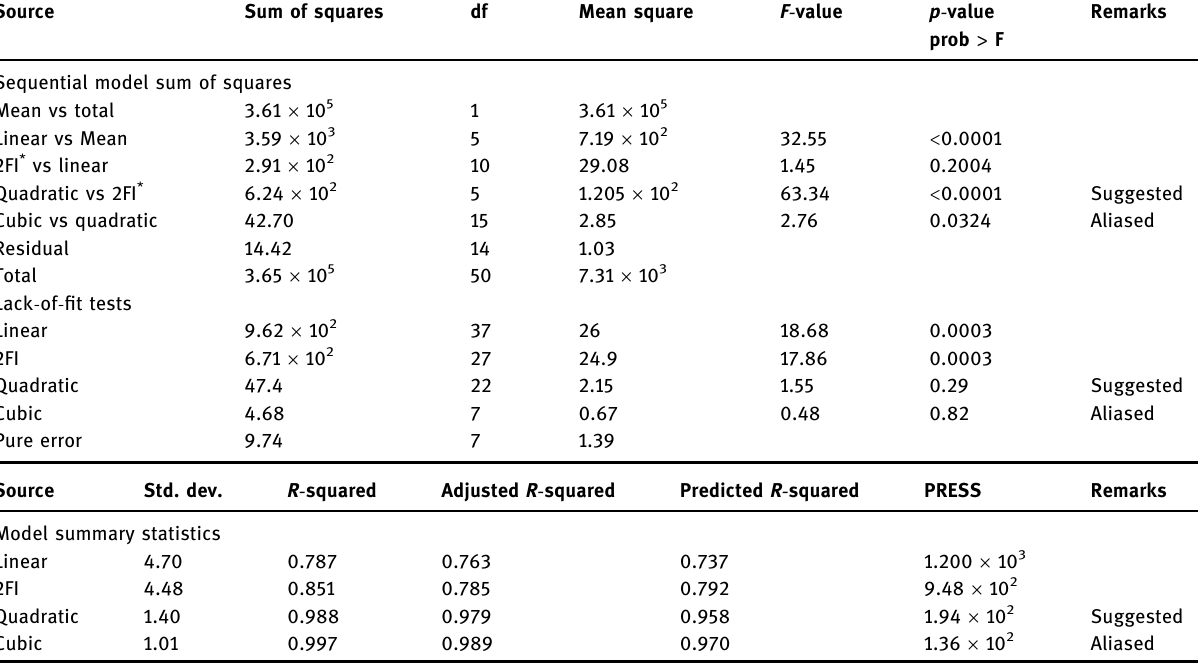
Table 5: Fit summary output as the sequential model sum of squares, lack - of - fi t tests, and model summary statistics Source Sum of squares df Mean square F - value p -